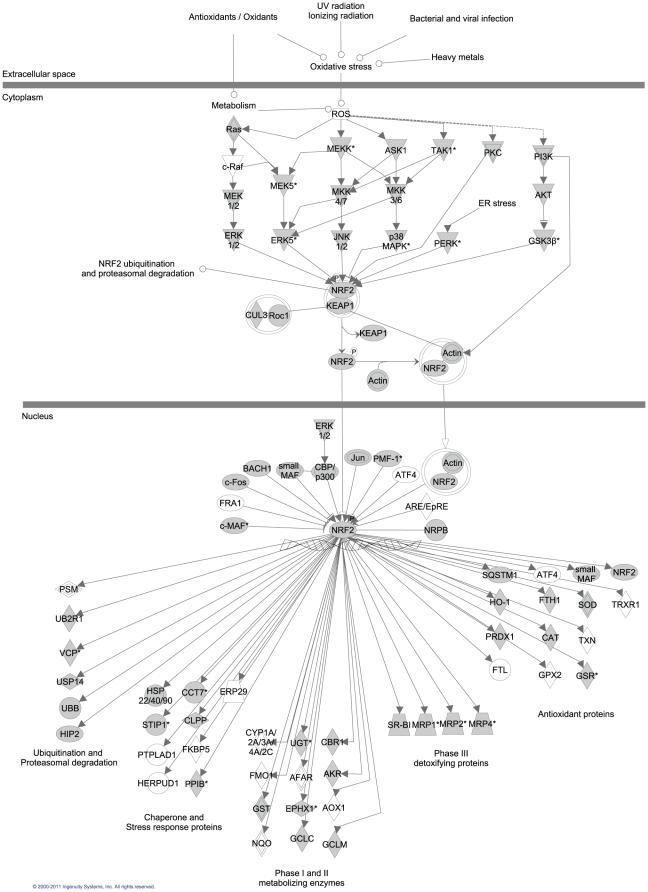
Homologs involved in canonical oxidative stress response pathways identified in the A. palmata transcriptome.Filled symbols indicate proteins with homologs that were detected in the A. palmata dataset. Unfilled symbols indicate proteins that were not detected in our data, but are present in model vertebrate pathways.